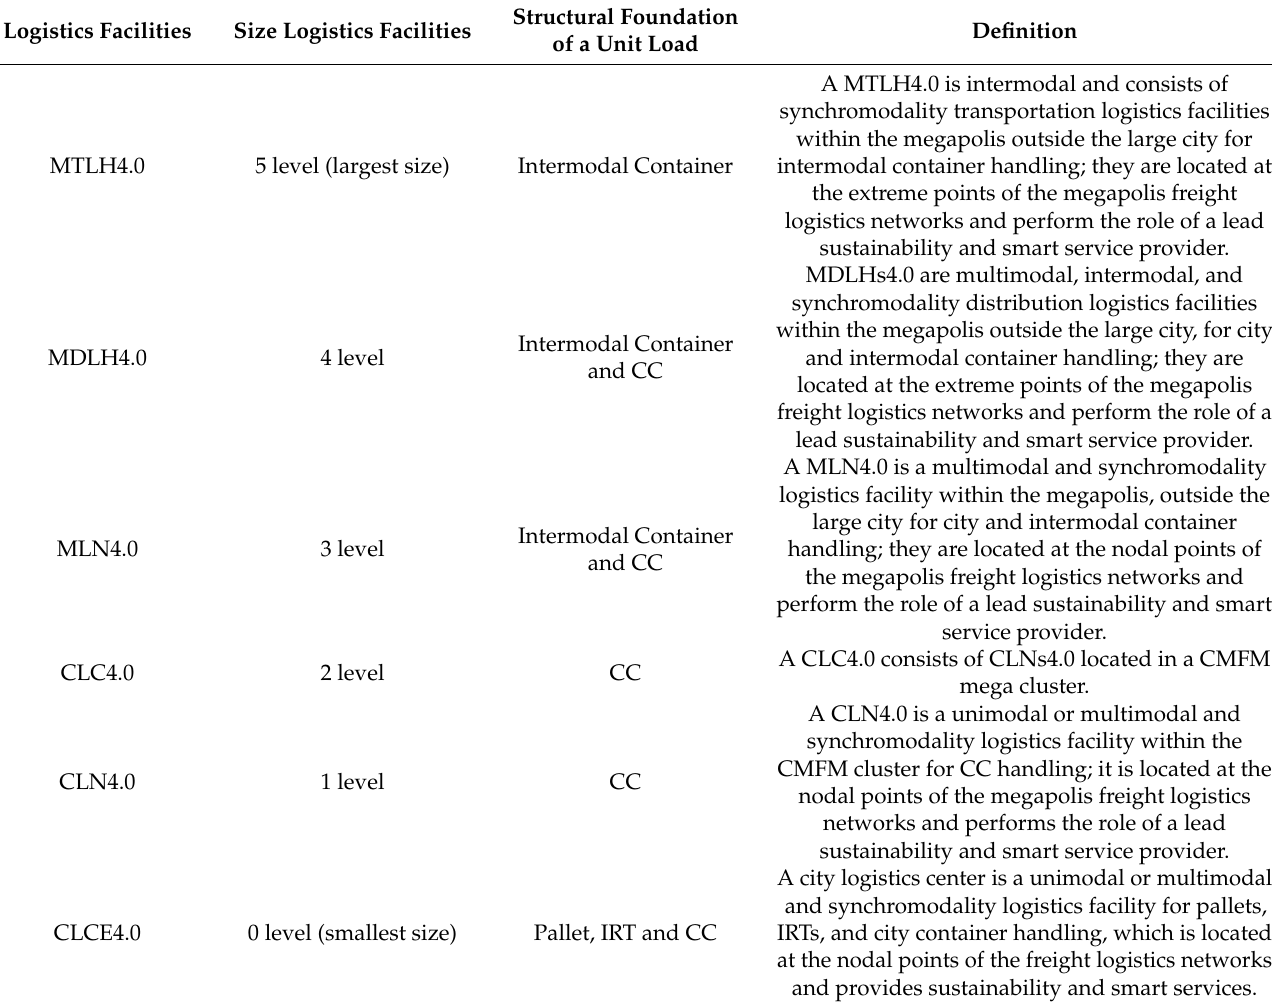
Table 1. Classification, hierarchy, and definitions of megapolis logistics